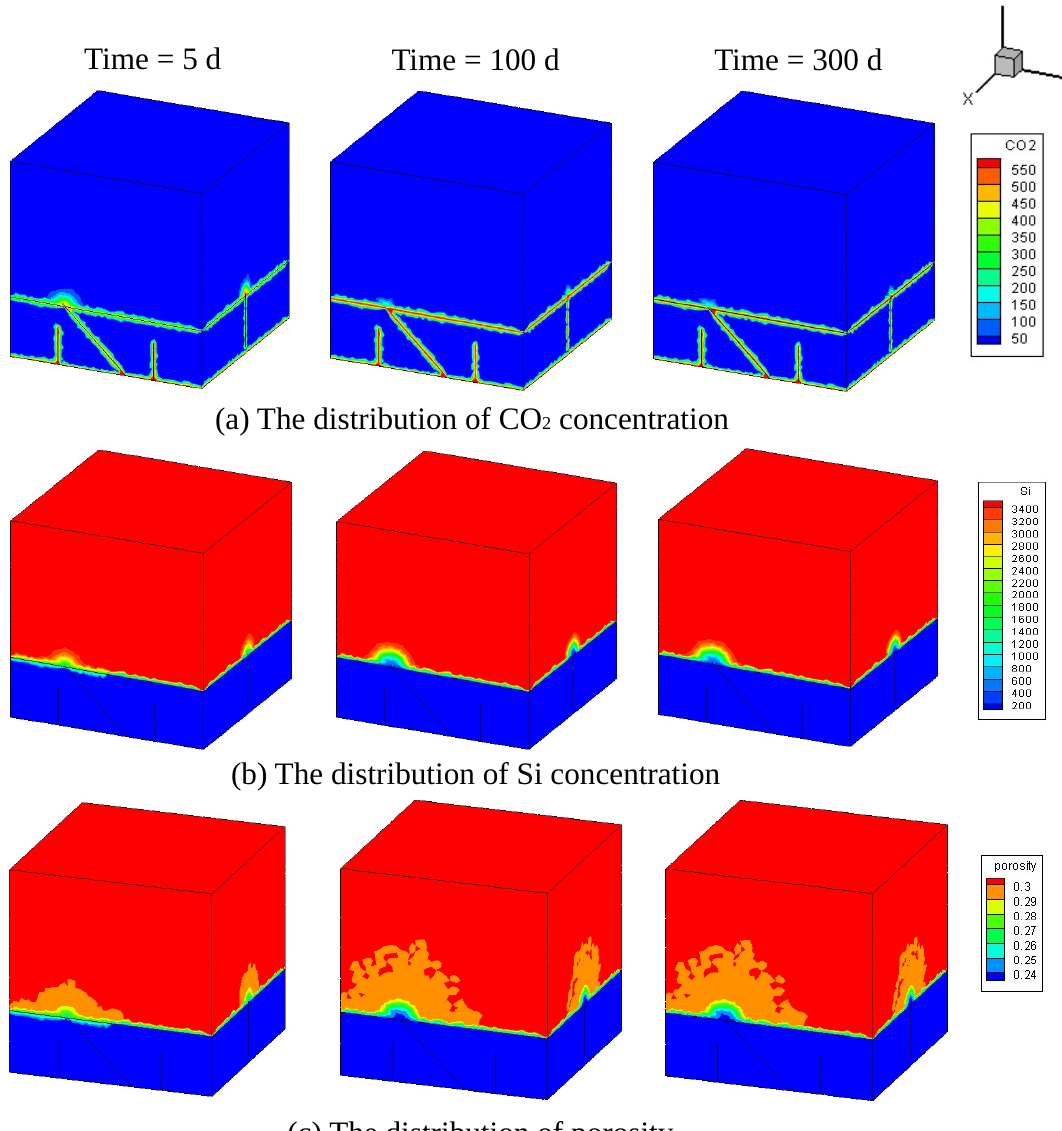
Figure 13. Numerical results of CO 2 sequestration at Si concentration of 3500 mol/m 3